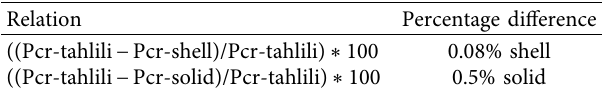
Table 5: Percentage difference of analytical solution and software solution for the least tension mode.